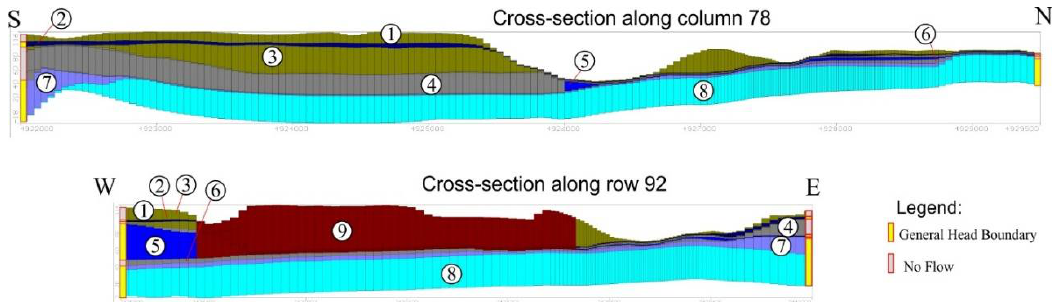
Figure 10. Schematic representation of the lithological section in the north–south (columns) and west– east (rows) directions. Key: 1. Clay sediments (Q); 2. Upper aquifer sands and gravel (Pl 1 ) 3. Aleurite sediments (Pl 1 ); 4. First coal bed (Pl 1 ); 5. Intermediate aquifer sands (Pl 1 ); 6. Second coal bed (Pl 1 ) 7. Lower aquifer of high hydraulic conductivity (Pl 1 ); 8. Lower aquifer sands of lower hydraulic conductivity (Pl 1 ); and 9. Heterogeneous material at waste disposal site.